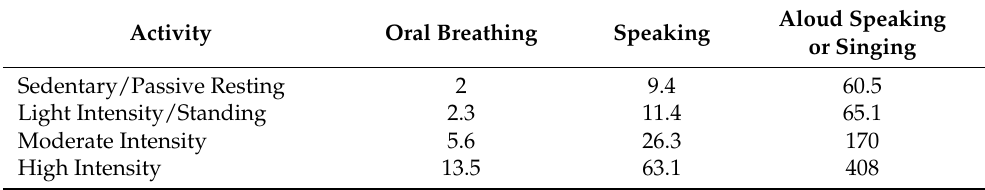
Aloud Speaking or Singing